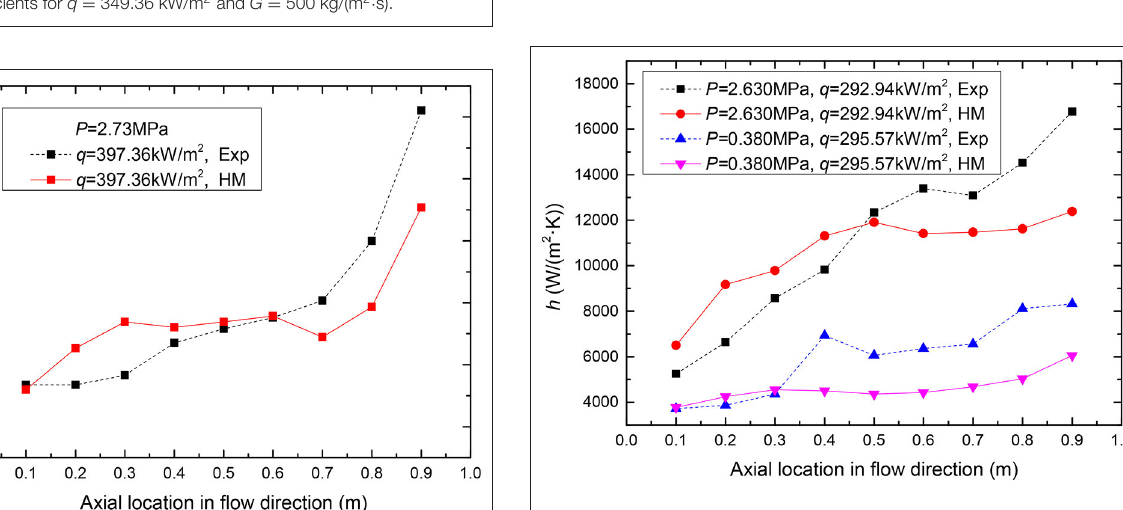
FIGURE 13 | The influences of the pressures on the heat transfer coefficients for q = 300 kW/m 2 and G = 300 kg/(m 2 · s).